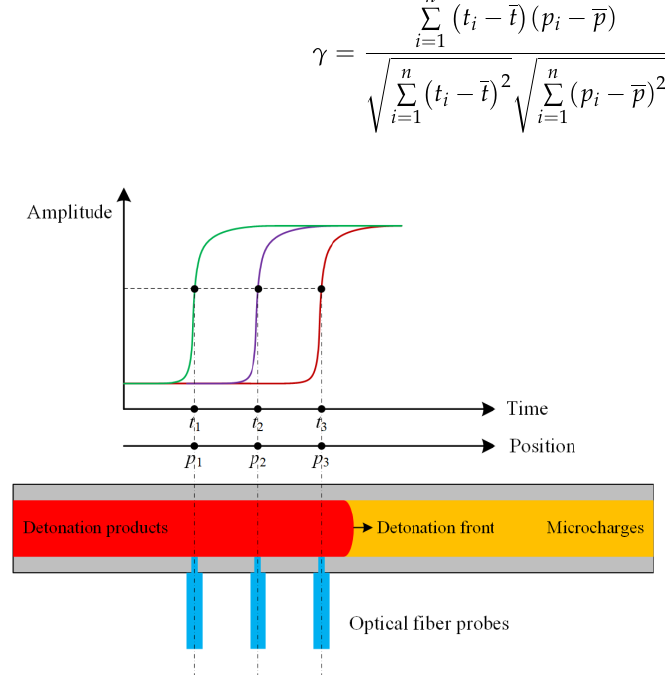
Figure 9. Schematic diagram of data acquisition.